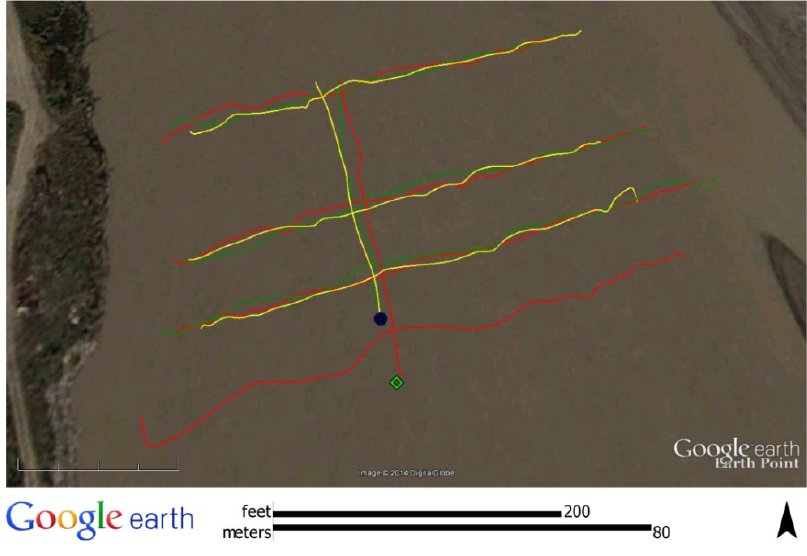
Figure 2. Cross-sectional transects and longitudinal profiles surveyed in the stream. Red indicates buoy only; green indicates the debris diversion device (DDD) minimum opening (approximately 30°); yellow indicates the DDD maximum opening (roughly 90°). The square (lime color) and the circle (blue color) indicate buoy and DDD locations, respectively. Flow direction, which is predominantly north, is from bottom to